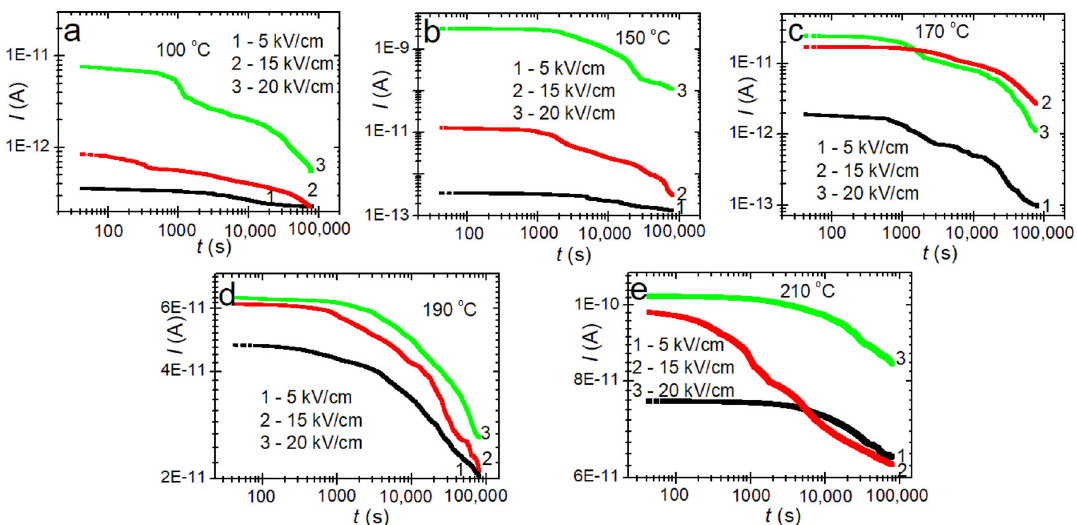
Fig. 5 Charging currents of NBT ceramics for applied electric fields of 5, 15, and 20 kV/cm at different temperatures. Note that both axes utilize a log scale.